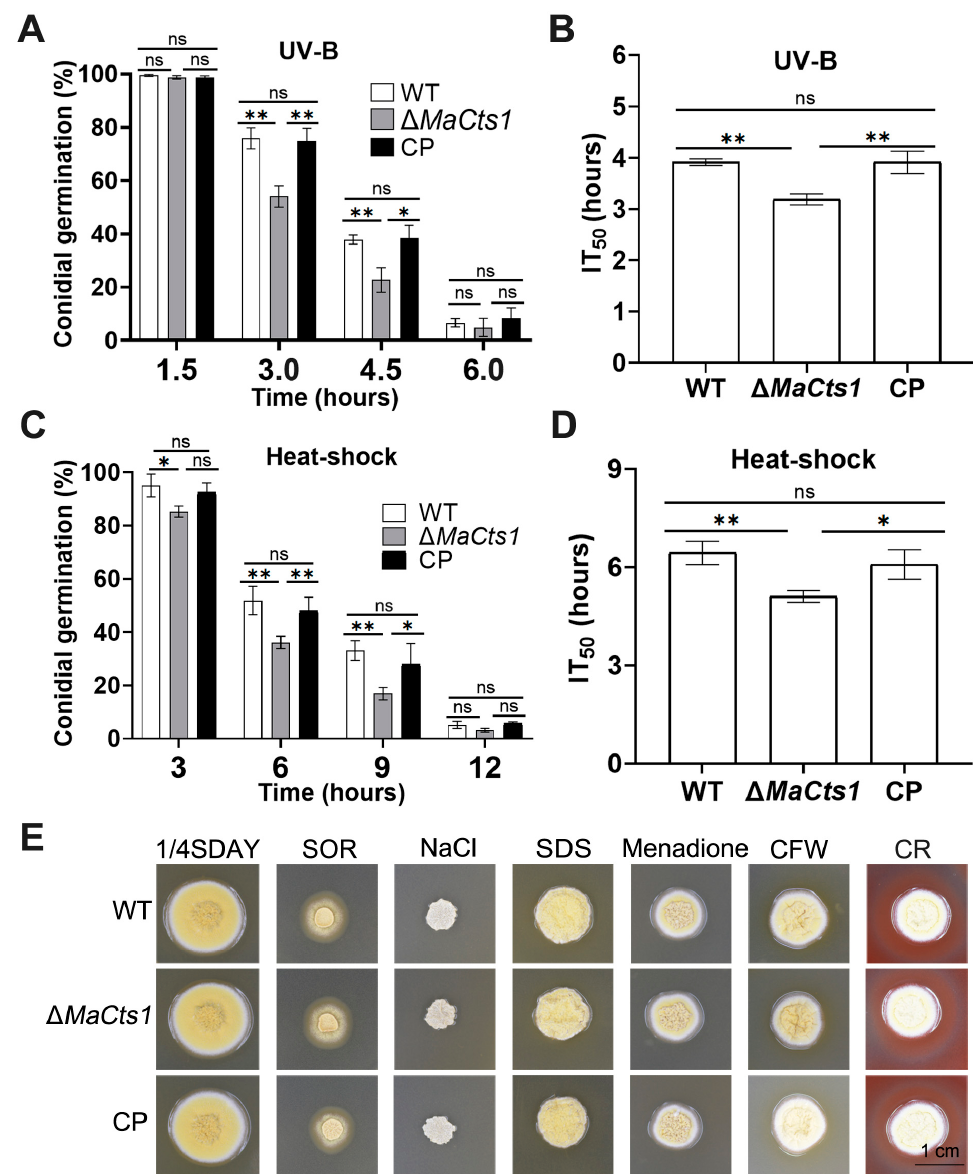
Figure 3. Stress tolerance assays of the WT, ∆ MaCts1 and CP strains. ( A ) The effect of UV-B irradiation on conidial germination (%) after UV-B irradiation followed by 20 h of cultivation on 1/4 SDAY medium at 28 ◦ C. ( B ) The median inhibition times (IT 50 s) of fungal strains treated by UV-B irradiation. ( C ) The effect of heat shock (44.5 ◦ C) on conidial germination. ( D ) IT 50 s of fungal strains treated by heat ‐ shock (44.5 °C). ( E ) Fungal colonies on 1/4 SDAY alone or supplemented with sorbitol (SOR; 1 mol/L), calcofluor white (CFW;50 μ g/mL), SDS (0.01% w / v ), NaCl (1 mol/L), congo red (CR; 500 μ g/mL), menadione (0.07% w / v ) and SDS (0.01% w / v ), respectively. Error bars indicate the standard deviation from triplicate experiments. One and two asterisks indicate a significant difference at p < 0.05 and p < 0.01, respectively. “ns” indicates no significant difference.